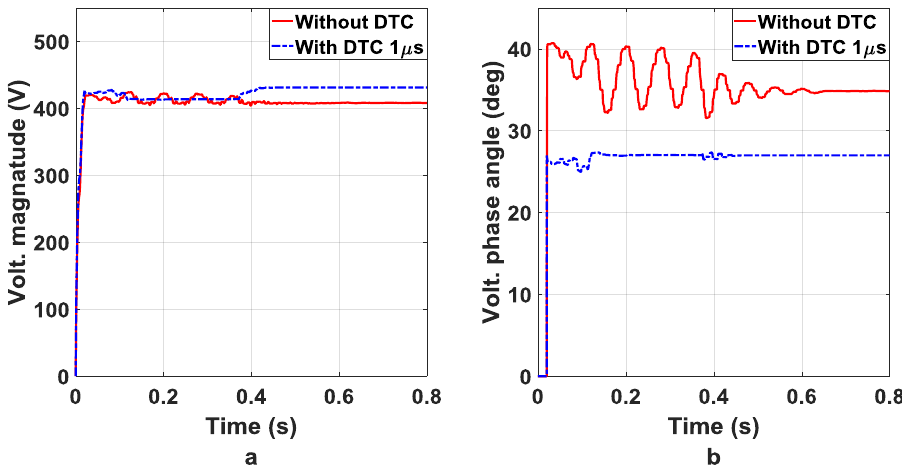
Figure 14. With/without DTC ( a ) fundamental voltage ( 𝑉 𝑎 ) magnitude ( b ) fundamental voltage ( 𝑉 𝑎 ) Figure 14. With / without DTC ( a ) fundamental voltage ( V a ) magnitude ( b ) fundamental voltage ( V a ) phase angle. phase